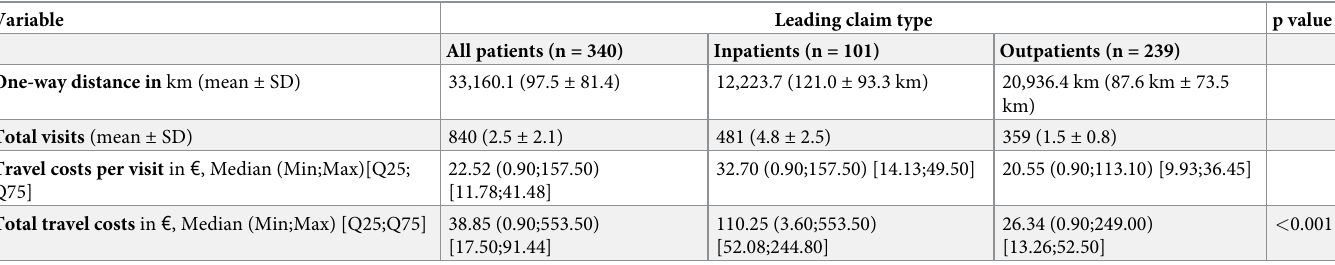
Table 3. Direct non-medical costs.